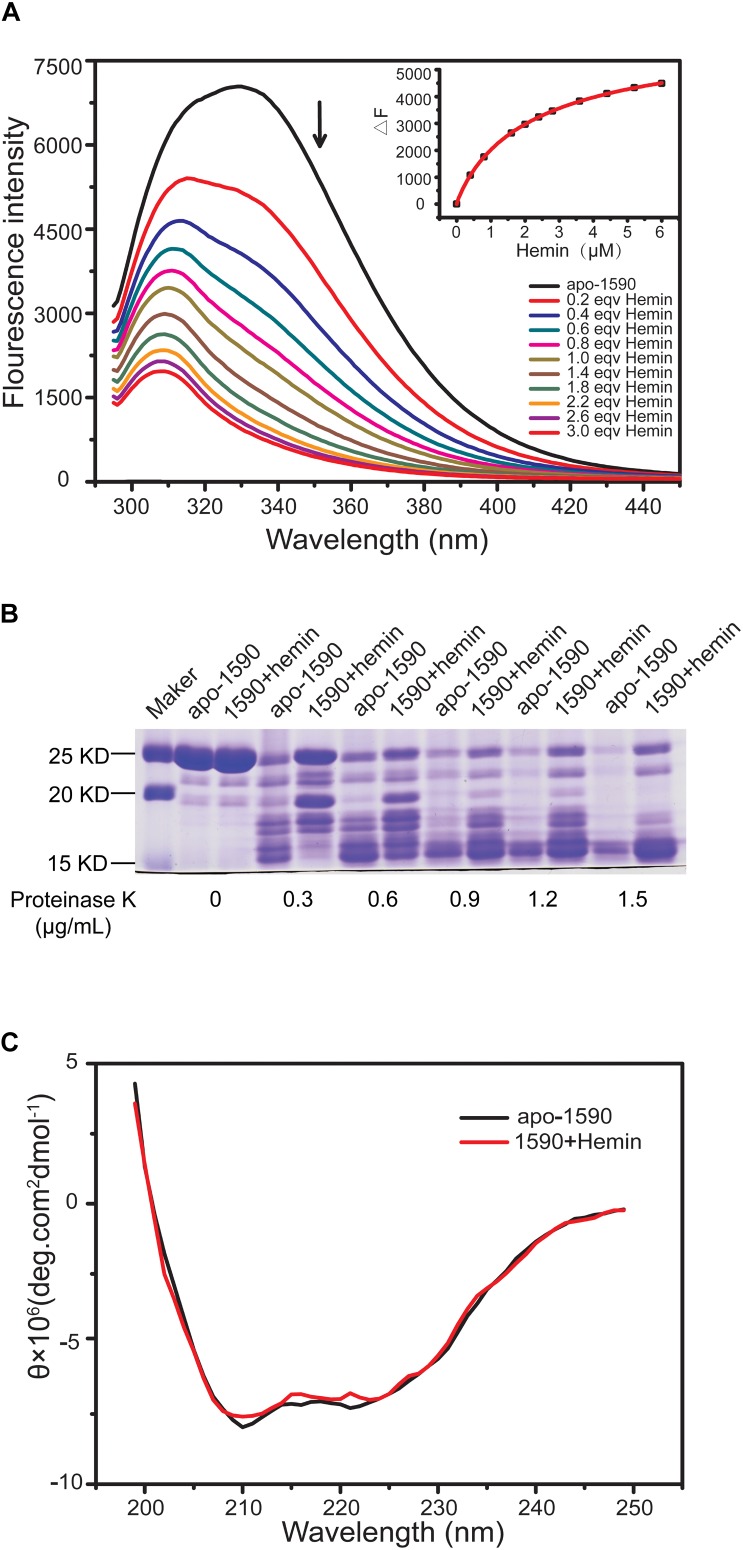
SPD_1590 binds with hemin. (A) Fluorescence spectra of hemin titration to apo-1590 (2 μM). (B) SDS-PAGE of apo-1590 and 1590+hemin pre-treated with 0, 0.3, 0.6, 0.9, 1.2, and 1.5 μg/ml proteinase K. (C) CD spectra of apo-1590 and 1590+hemin.